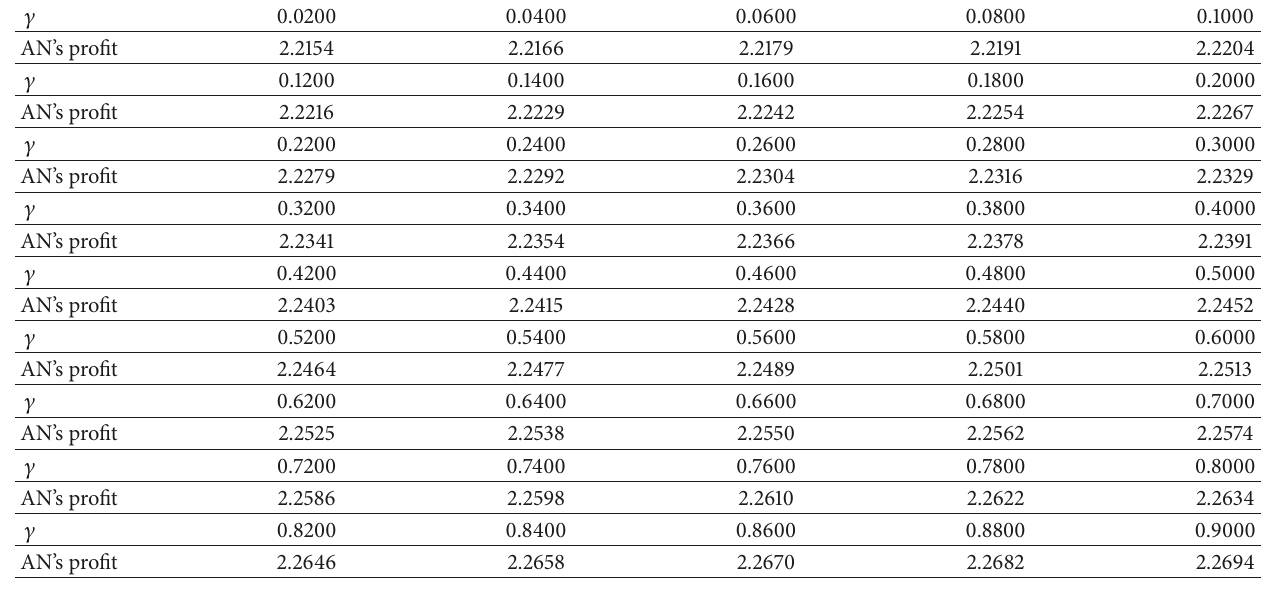
Table 5: Second stage utility of AN when AN participates.